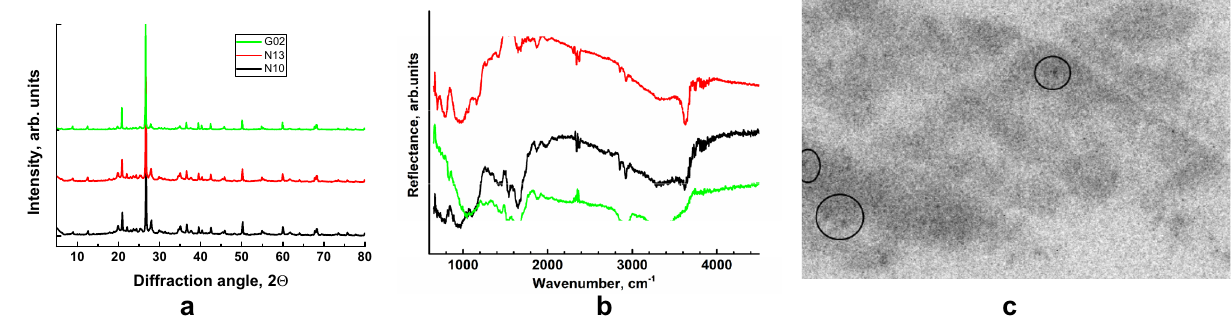
Figure 7. Representative X-ray diffraction patterns ( a ) and infrared spectra ( b ) for cryoconite from Novaya Zemlya (N10 and N13 correspond to 1710 and 1713—Nalli Glacier, zone A) and Svalbard (G02—Vestre Grønfjord Glacier). The curves are displaced vertically for clarity. Autoradiograph ( c ) of a powdered cryoconite sample (horizontal size 5 cm). The darkening is uniform and precisely matches the distribution of the powder. Circles mark spots with higher